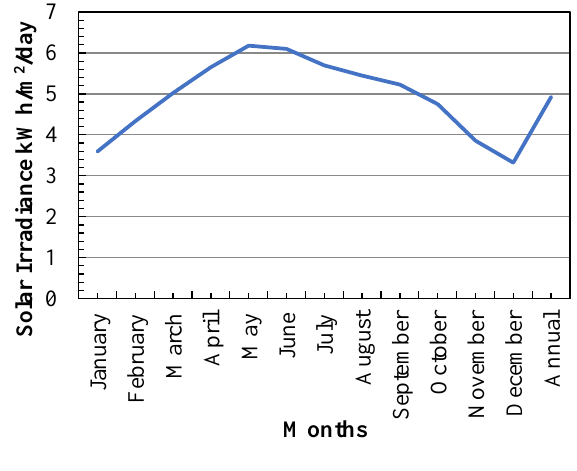
Fig. 7. Monthly solar irradiance